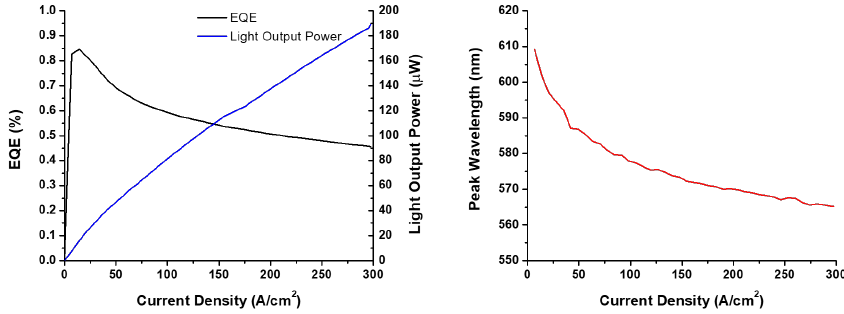
Figure 3. Plots of EQE and peak wavelength for selected representative 80 × 80 µ m 2